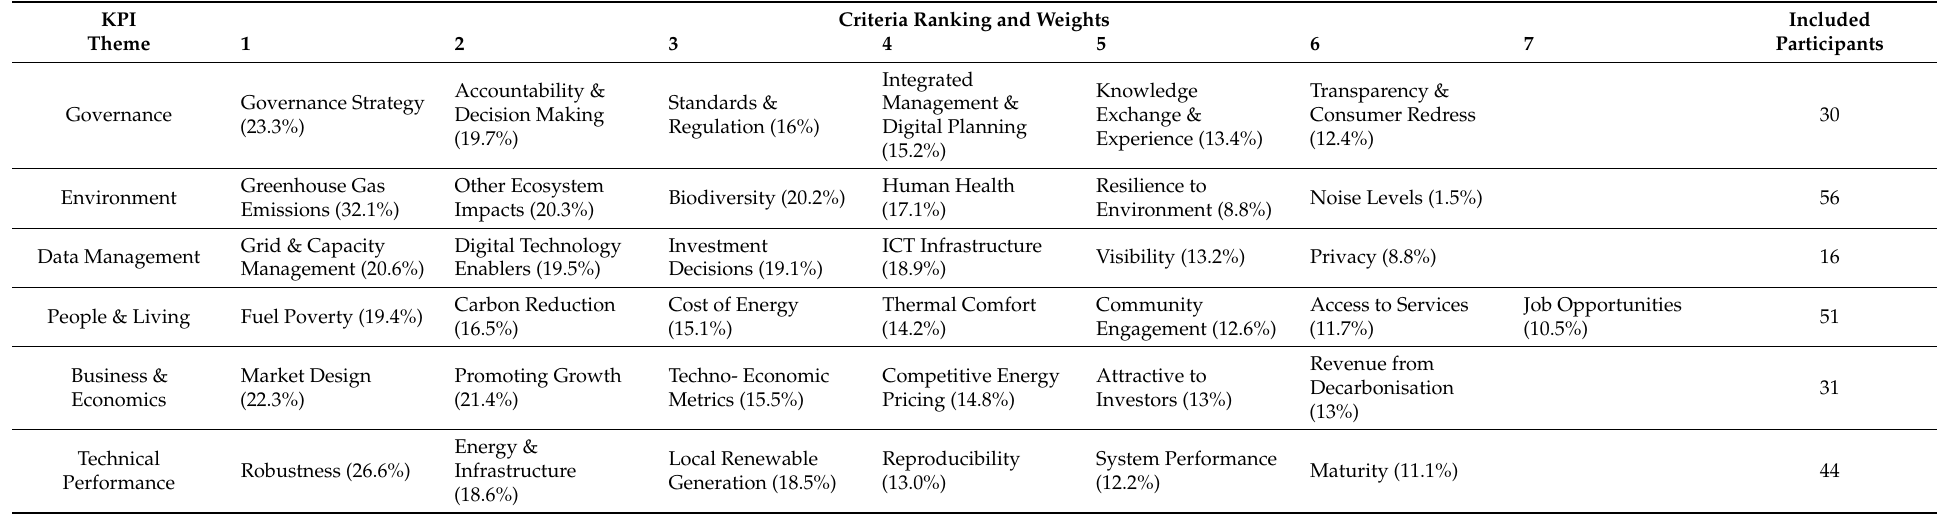
Table 3. Theme-specific KPI weightings calculated from the DCE thematic surveys.